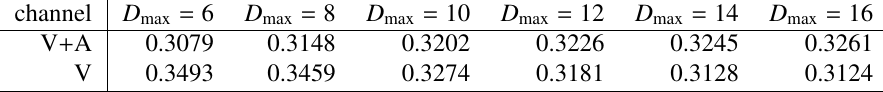
Table 1. The extracted values of α s ( m 2 ), for FO approach, for di ff erent truncations of the OPE: D max is τ the maximal dimension D = D max at which the OPE is truncated. The values are given for the (V + A)-channel and the V-channel. The truncation index of the D = 0 sum rule contribution is N t =